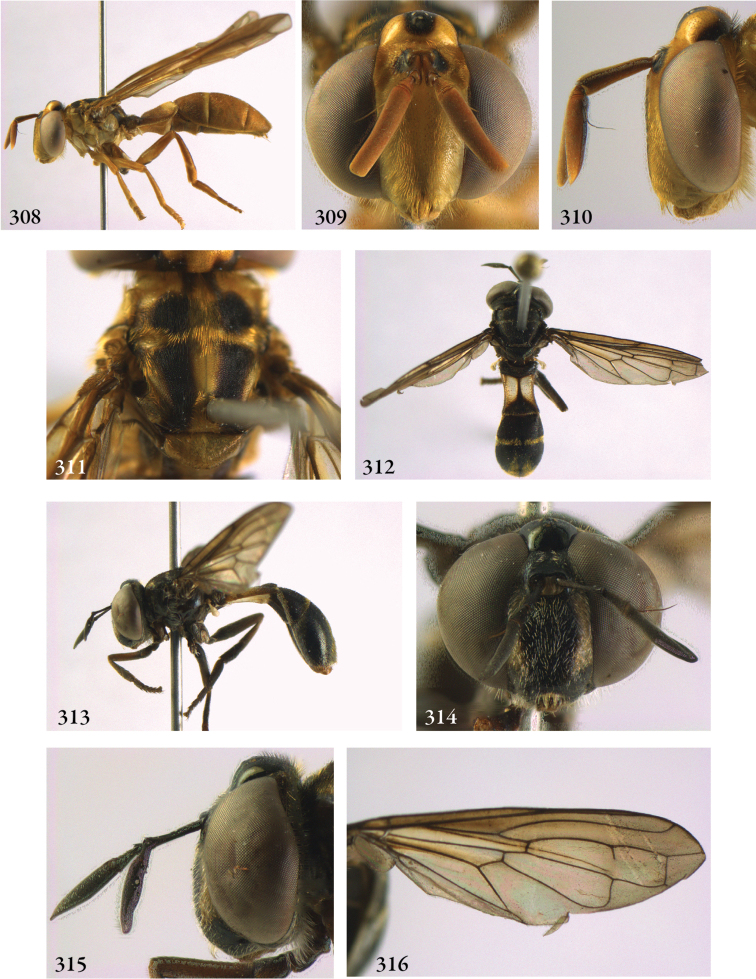
308–311
Pseudomicrodon polistoides female (holotype) 308 habitus lateral 309 head frontal 310 head lateral 311 thorax dorsal 312–316
Pseudomicrodon smiti male (holotype): 312 habitus dorsal 313 habitus lateral 314 head frontal 315 head lateral 316 wing.